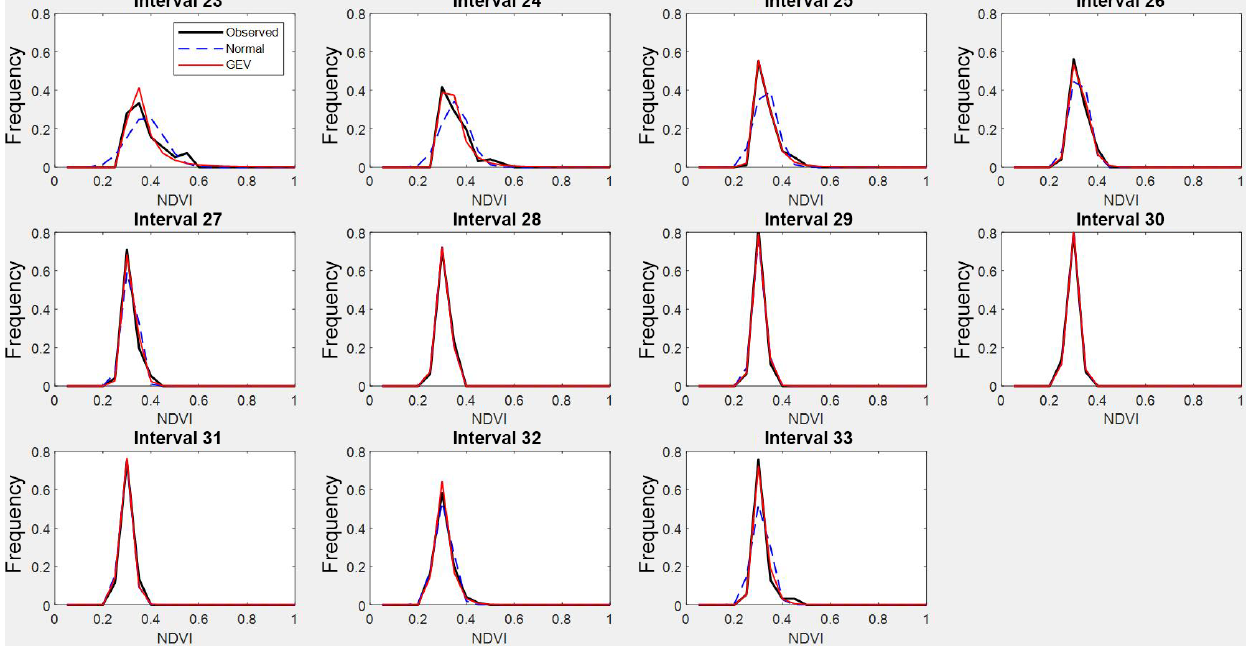
Figure A3. Observed NDVI, GEV and normal probability density functions from interval 23 to interval 33 (from 26 June to 21 September) representing